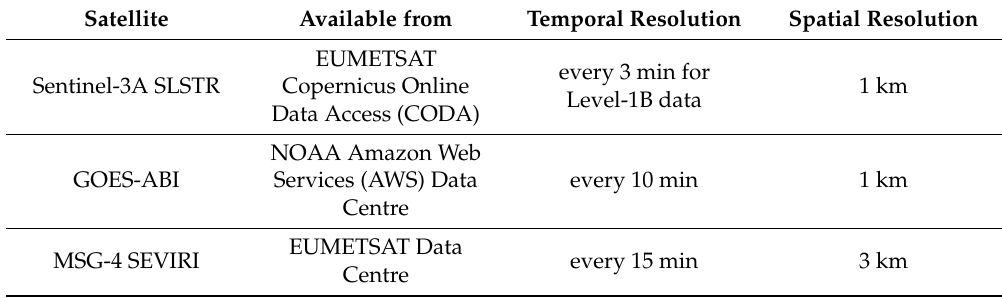
Figure 2. The Sentinel ‐ 3A one ‐ day ground tracks along with the coverage areas of the two geostationary meteorological satellites currently in operation and are used in this study. May 2020 monthly mean SST is the background. Three black rectangles indicate the research areas in this study, the numbers correspond to the three parts in Section 4. Table 2. Characters of each satellite product. Table 2. Characters of each satellite